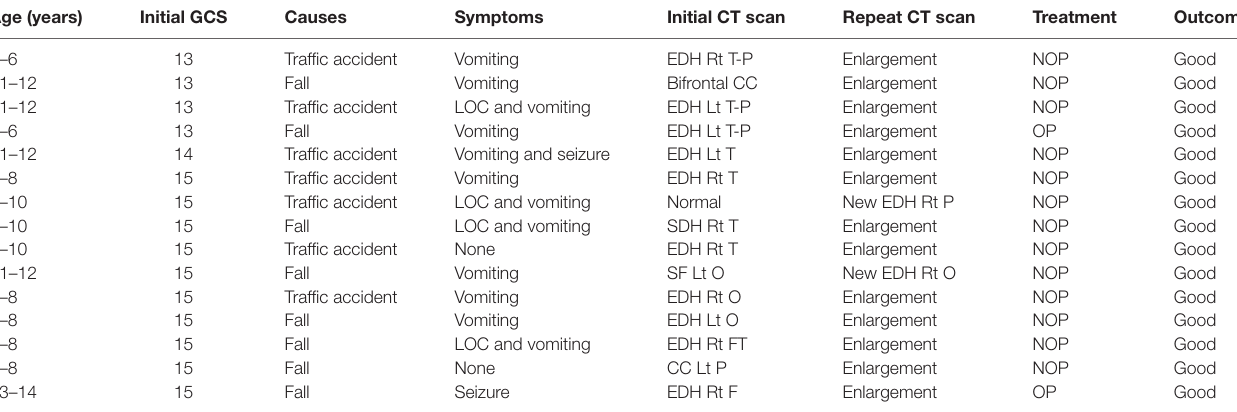
TaBle 2 | Characteristics of patients who experienced progressive hemorrhagic